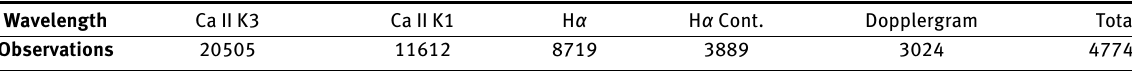
Table 1. Total numbers of observations from January 1st, 1926, to Abril 30th, 2019.